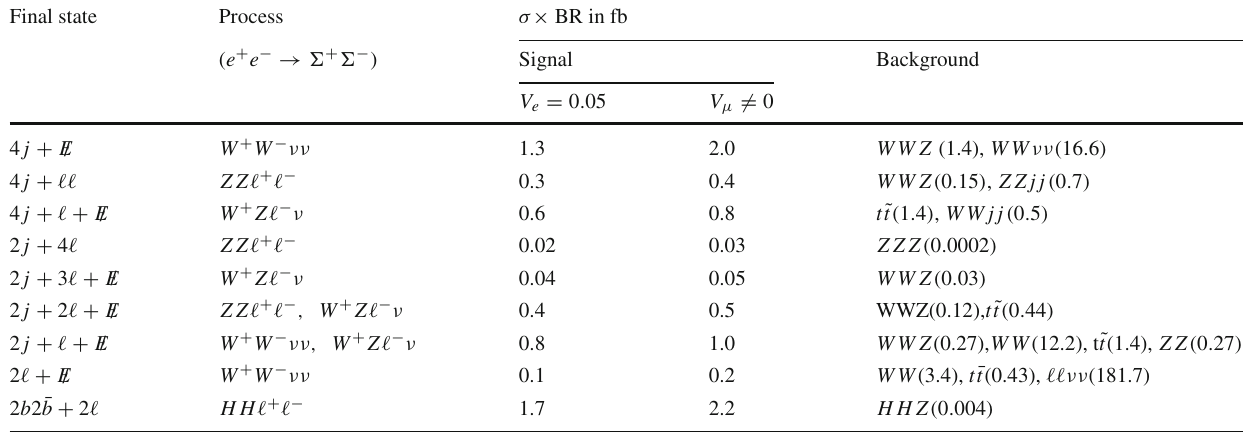
Table 6 Final state fiducial cross sections of the signal from e + e − → (cid:2) − (cid:2) + , and the corresponding SM background processes, with the selectionof p T ((cid:4)) ≥ 10 GeV, pseudo-rapidity of leptons | η (cid:4) | ≤ 2 . 5and